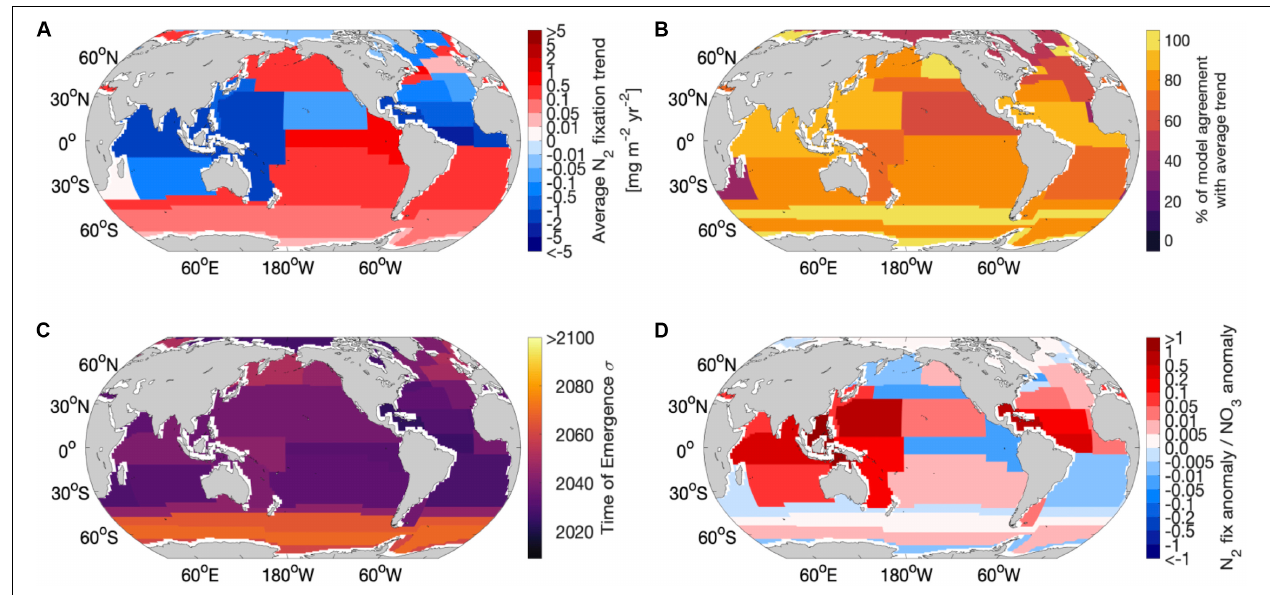
FIGURE 3 | Regional comparison of the 9 global nitrogen fixation models using Longhurst provinces: (A) average trend of nitrogen fixation across all 9 models in each province, (B) percentage of models that agree with the average trend for each province, (C) average time of emergence across all 9 models for each province using 1 standard deviation of the control and (D) the contribution of the nitrogen fixation anomaly to the NO 3 anomaly.